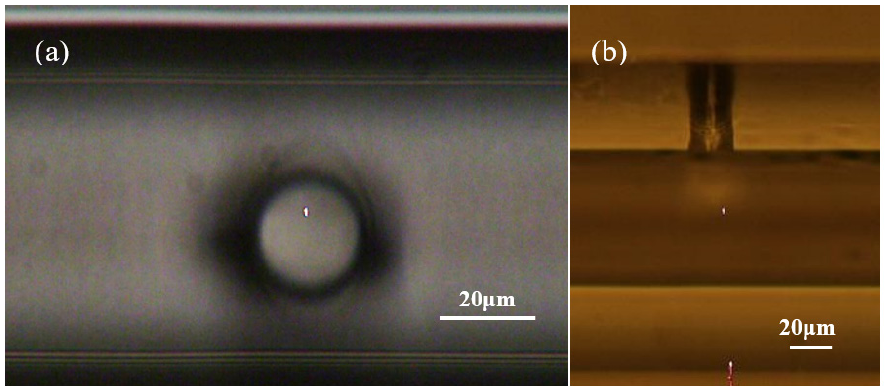
Figure 3. Microscopic images of single hole drilled in a HCF. ( a ) Front view; ( b ) Side view.